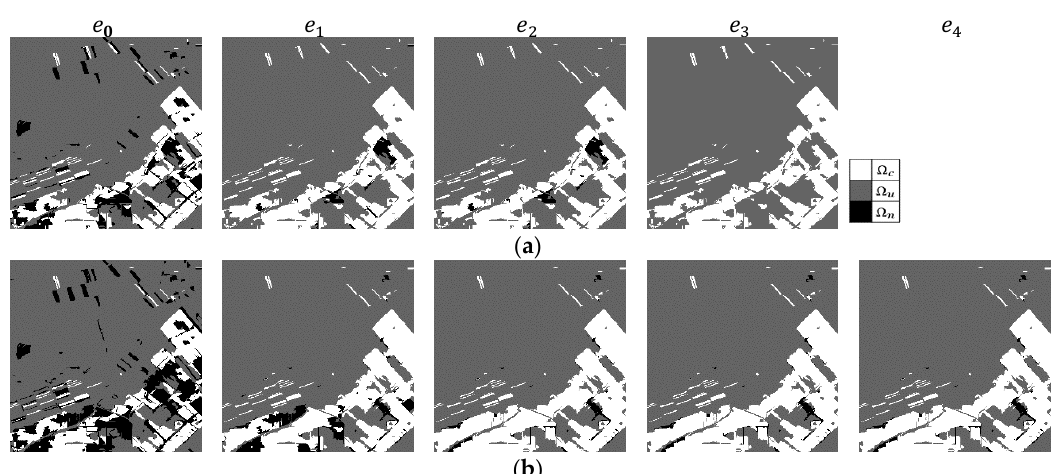
Figure 15. The CD results of the proposed methods for each epoch. The uncertainty level decreased at Site 1: ( a ) from Level 3 to Level 1; and ( b ) from Level 2 to Level 1. Grey ( Ω c ) , white ( Ω u ) , and black ( Ω n ) colors represent the change, no-change, and no-value classes, respectively.